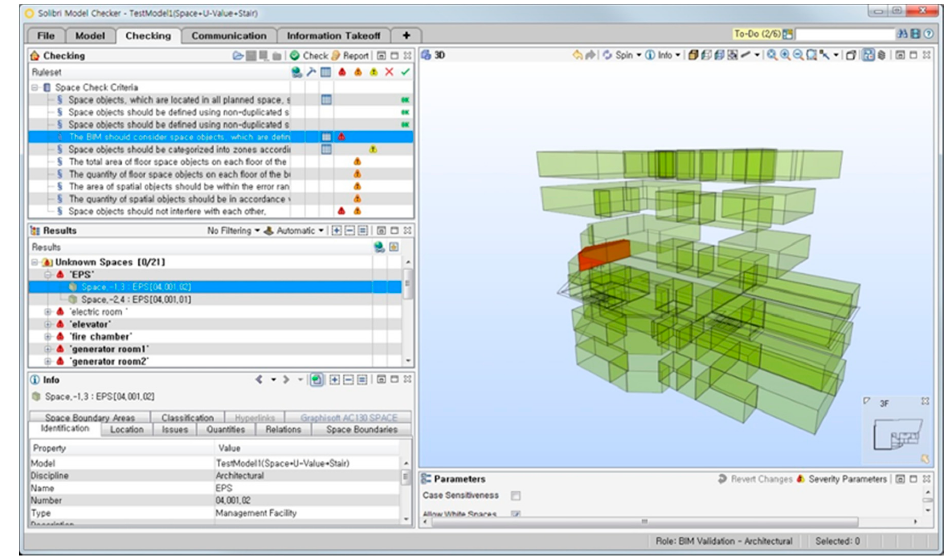
Figure 3. Example of quality check according to the space check criteria.